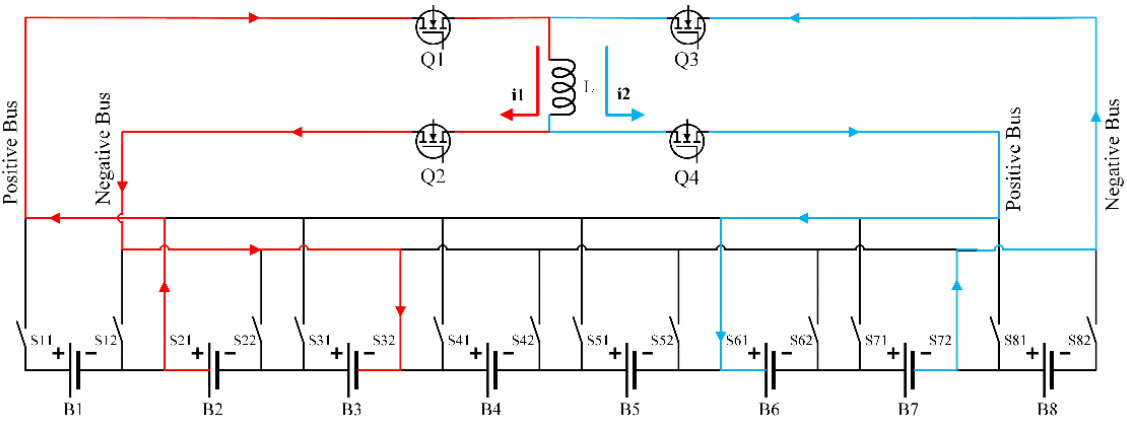
Figure 4. Multi-cell-to-multi-cell balancing.